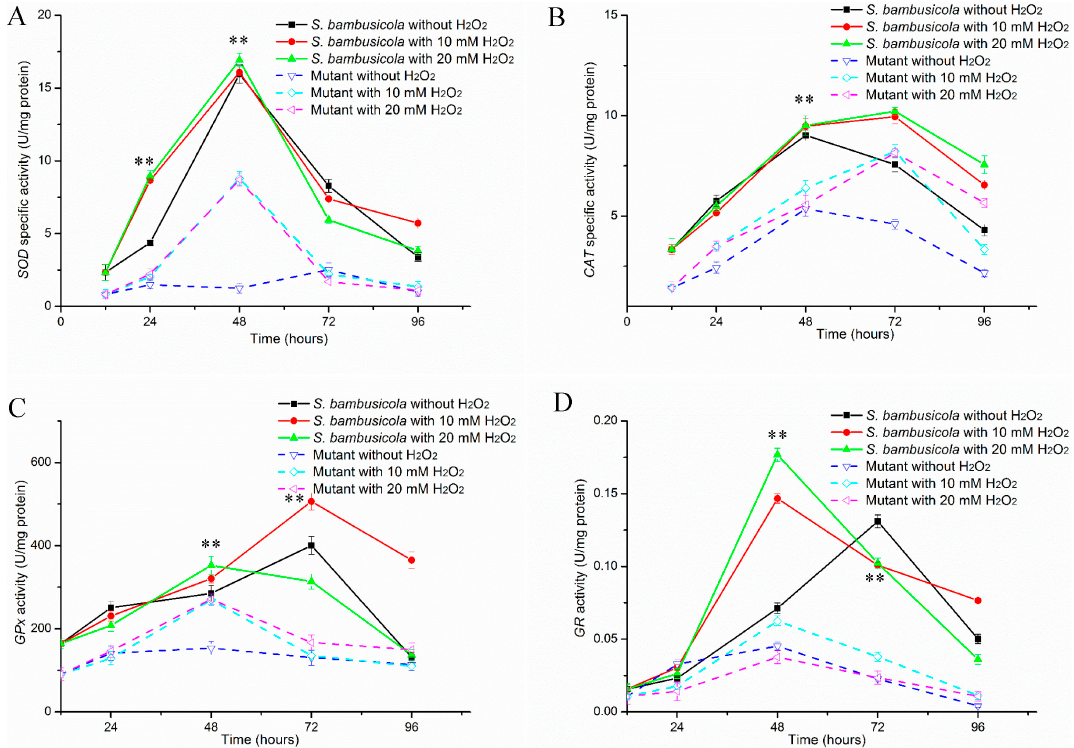
Figure 3. Effects of H 2 O 2 addition on SOD ( A ); CAT ( B ); GPx ( C ); and GR ( D ) production of S. bambusicola and a hypocrellin-deficient mutant. ** p <